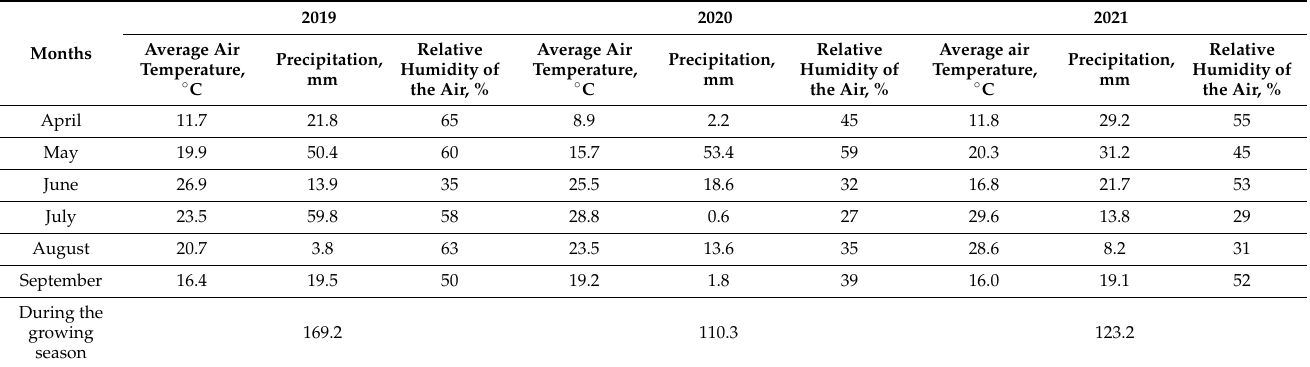
Table 1. Meteorological conditions during the years of research (average for